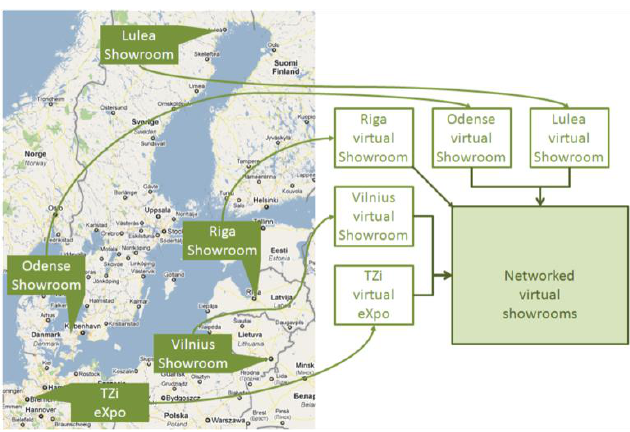
Fig. 7. From real showrooms to a network of virtual showrooms.